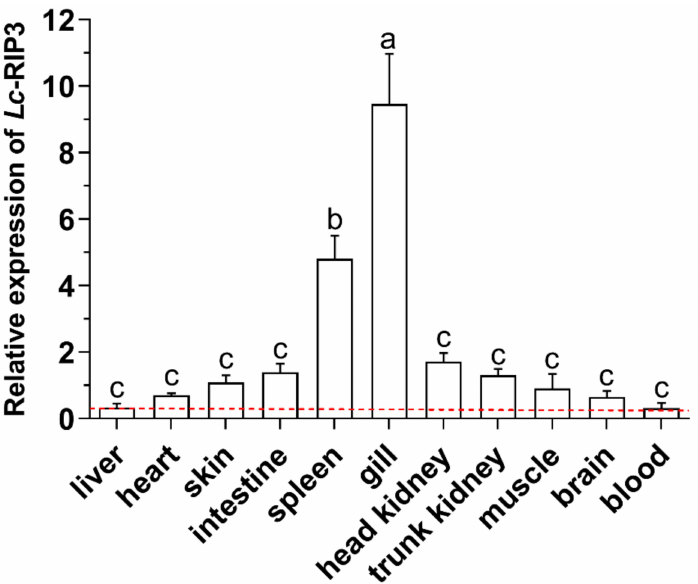
Figure 5. Distribution pattern of Lc - RIP3 mRNA in large yellow croakers. The mRNA expression levels of Lc - RIP3 in various organs/tissues of healthy fish ( n = 6) were detected by qRT-PCR with the results normalizing the expression of β -actin. The expression levels in 11 organs/tissues were set as multiples relative to the average expression of Lc - RIP3 in all tissues and the baseline of the lowest expression level was marked with a red dotted line. All data are shown as mean ± SE ( n = 6). A statistical analysis was performed using a one-way ANOVA followed by a Duncan’s multiple range test. Different superscripts indicate statistically different results ( p < 0.05) and the same superscript indicates no statistical differences between